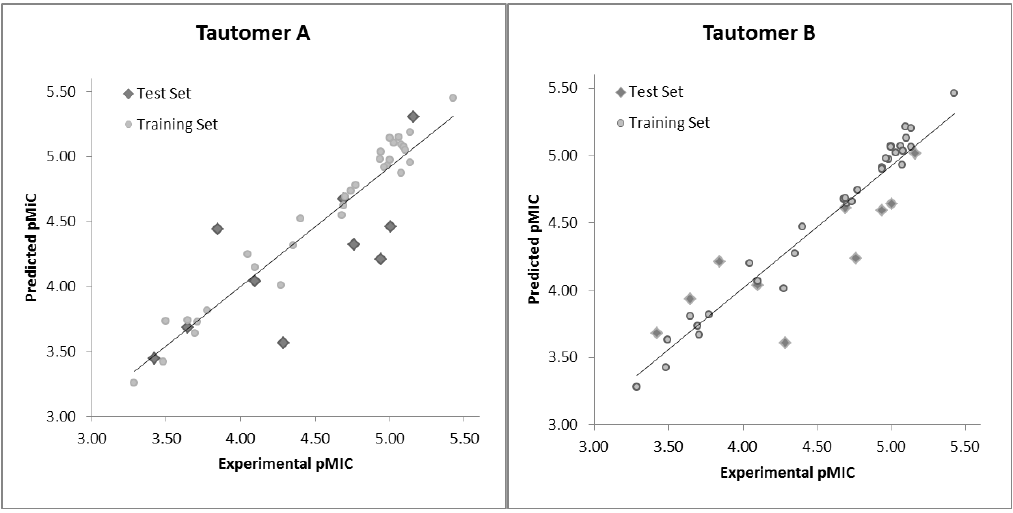
Figure 2. Plot of the experimental versus predicted pMIC values of the training and test sets of the tautomers I (amino) (A) and II (imino) (B) datasets.